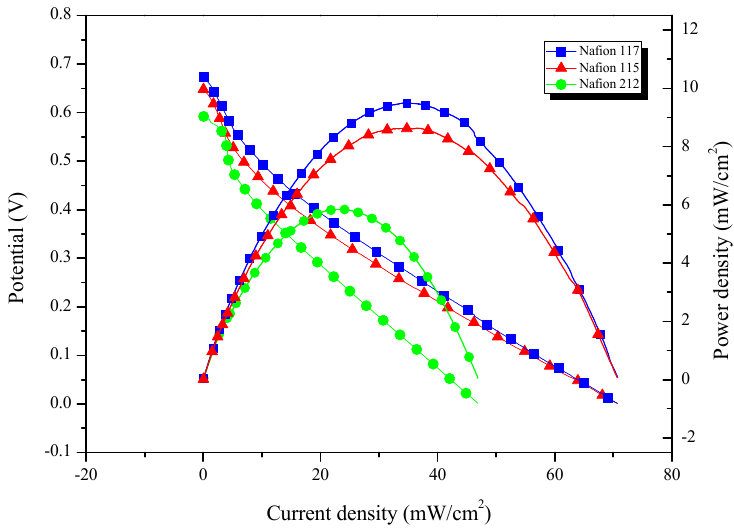
Figure 11. Polarization curves of DMFC with different proton exchange membranes (PEMs).